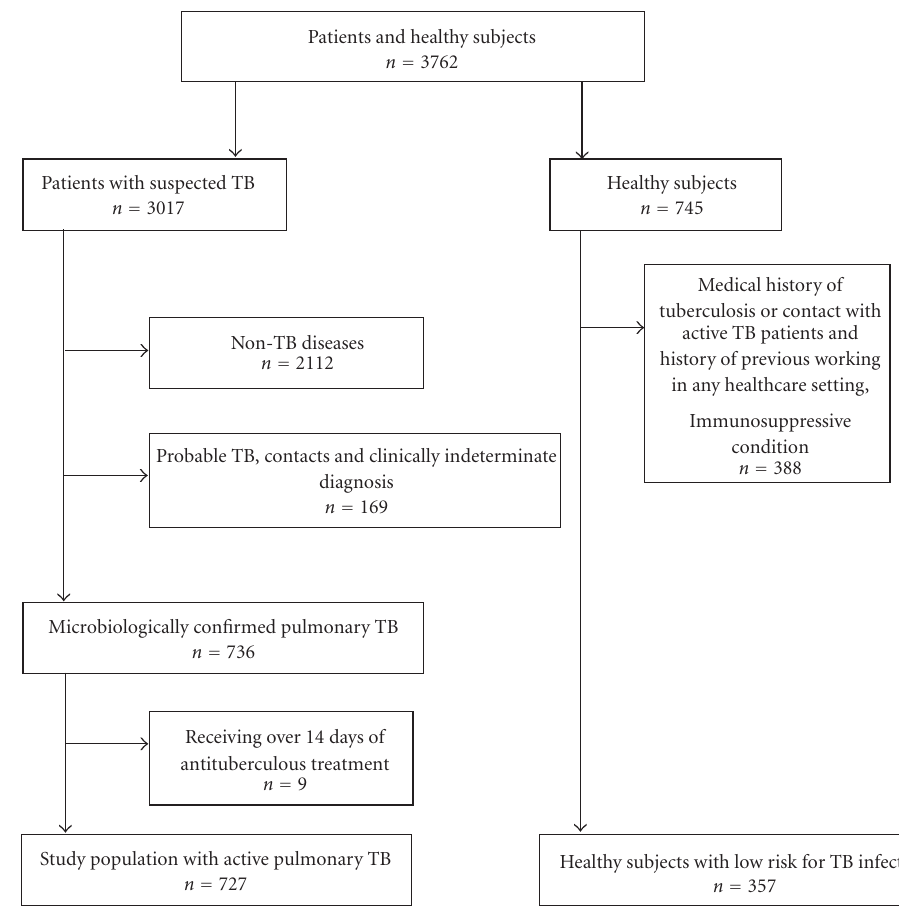
Figure 1: Study participants recruitment profile. TB: